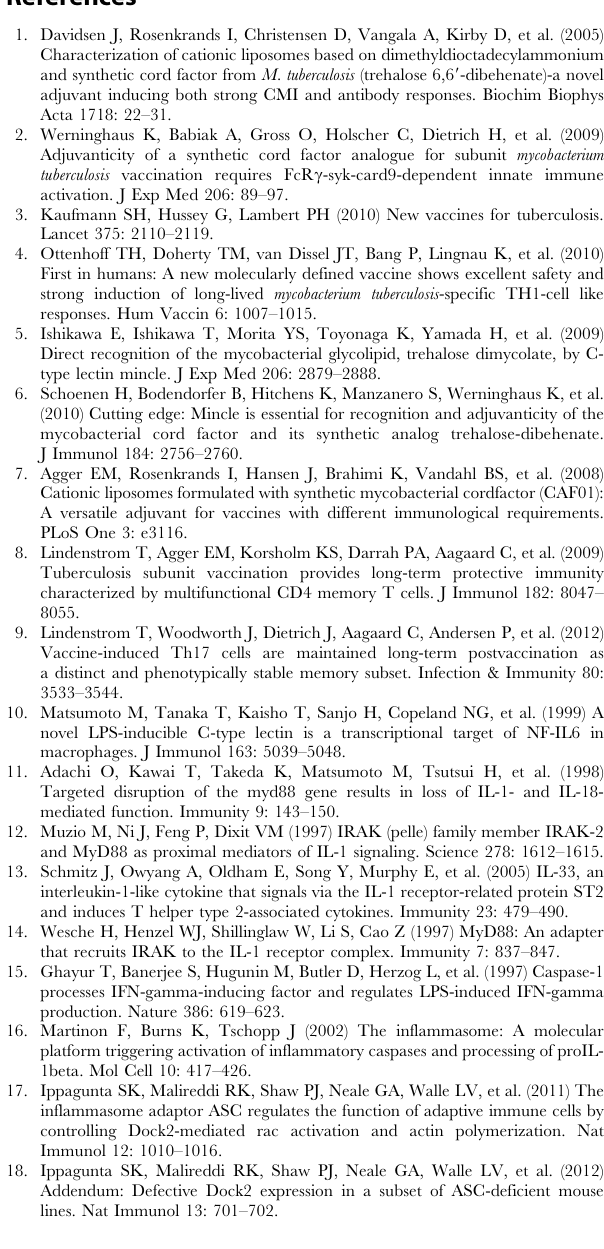
Figure S4 ASC 2 / 2 macrophages show no defects in spreading kinetics and phagocytosis capacity. Spreading kinetics ( A ) of C57BL/6 (circles) and ASC 2 / 2 (squares) BMM stimulated with LPS (closed symbols) or media control (open symbols). Mean 6 SEM of at least 300 cells per condition. Statistical significance refers to the comparison of LPS stimulated C57BL/6 and ASC 2 / 2 BMM. One experiment performed. Phagocytosis capacity of C57BL/6 ( B ) and ASC 2 / 2 ( C ) BMM. Cells were incubated with fluorescent latex beads (1 m m; MOI 20) for 1 h and 4 h. Percentages of cells which phagocytosed beads determined flow cytometry. One of two representative experi- ments